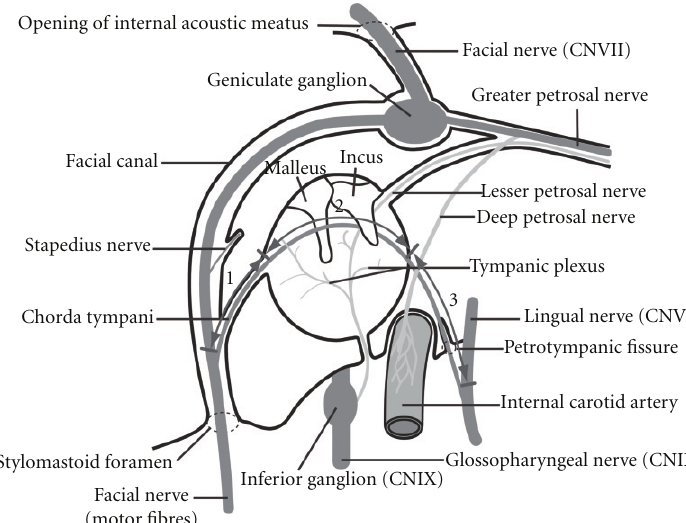
Figure 1: The sections of the chorda tympani between the facial nerve and lingual nerve via the tympanic cavity. Section 1: mastoid process, section 2: tympanic cavity, section 3: submandibular